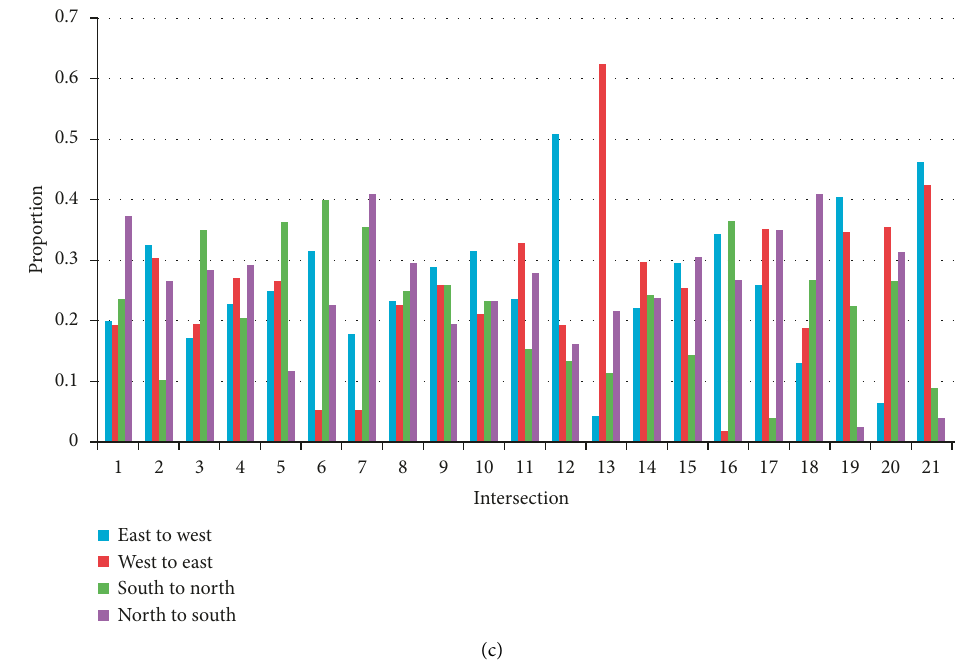
Figure 5: The proportion of vehicle trips in four driving directions: (a) mode-1, (b) mode-2, and (c)